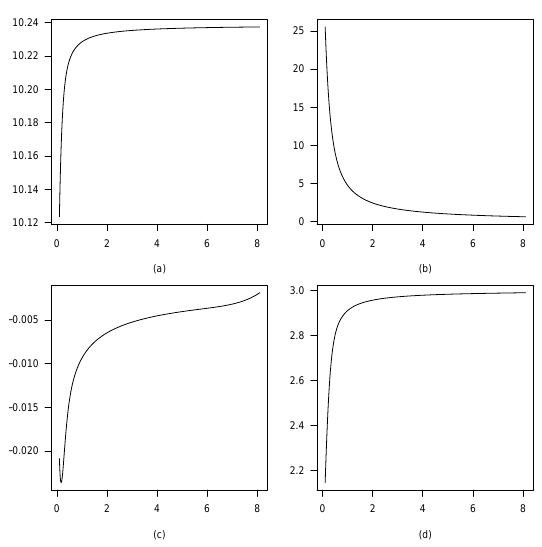
Figure 15 – Mean, in panel (a), variance, in panel (b), skewness, in panel (c), kurtosis, in panel (d), of the intermediate hypergeometric distributions { q α >